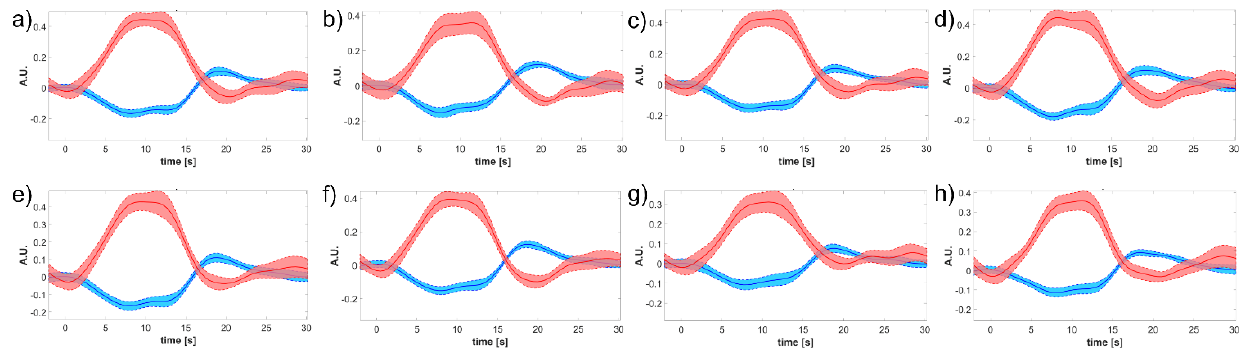
Figure 7. Subject-specific block-averaged responses across pipelines of Δ[HbO 2 ] and Δ[HbR] re- lated to left-hand motor grasp and a measurement channel placed over the right motor region (i.e., contralateral hemisphere). ( a ) SC-MARA-spline, ( b ) MC-MARA-spline, ( c ) SC-MARA-tPCA, ( d ) MC-MARA-tPCA, ( e ) HybridMARA-spline SG, ( f ) HybridMARA-tPCA SG, ( g ) TDDR, and ( h ) Wavelet method.